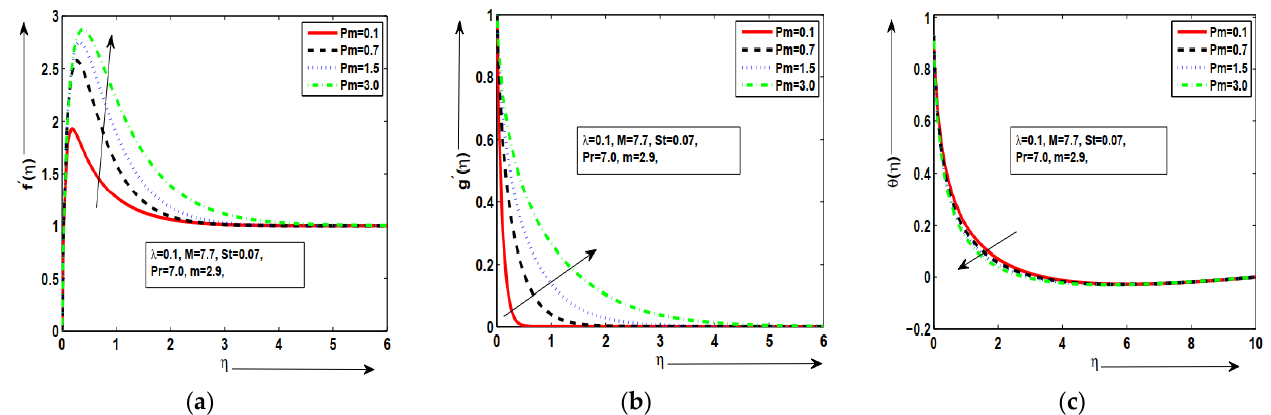
Figure 5. ( a – c ) The geometric profiles of f (cid:48) ( η ) , g (cid:48) ( η ) , and θ ( η ) against P